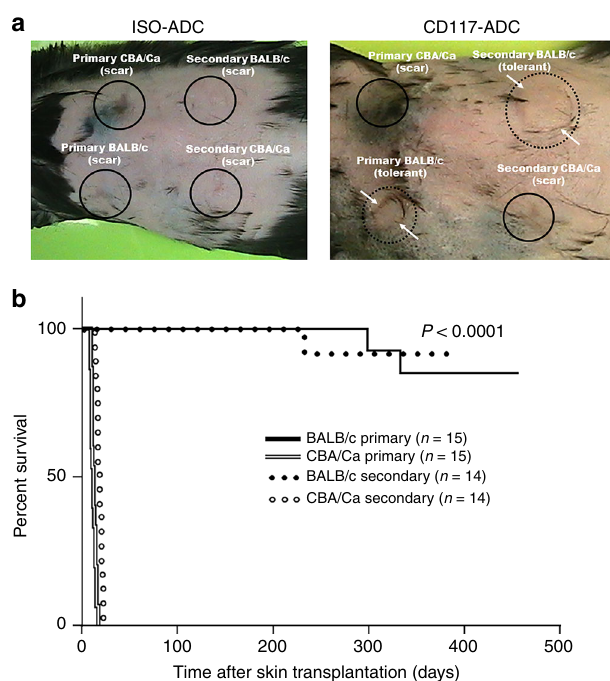
Fig. 2 Robust donor-speci fi c tolerance after CD117-ADC conditioning and fully MHC-mismatched sequential bone marrow and skin allotransplantation. C57Bl/6 animals were conditioned as indicated at the top of each panel, then transplanted with 2 × 10 7 total BM cells, followed by skin allotransplantation, according to the protocol shown in Fig. 1a.